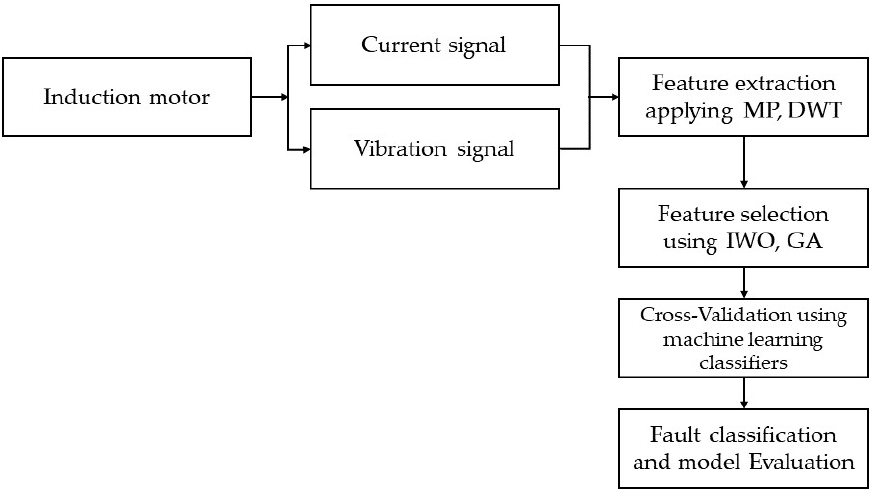
Figure 7. Schematic diagram of the proposed methodology [38].